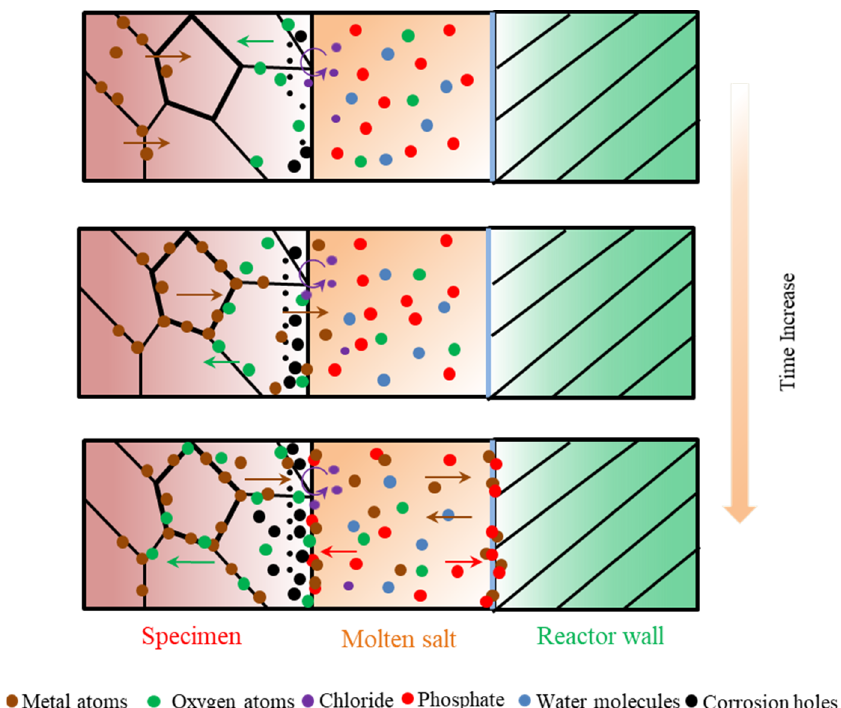
Figure 9. Corrosion dynamic mechanism diagram of 316 SS, Alloy 625, and TA8 exposed to supercritical water containing phosphate, chloride, and oxygen.